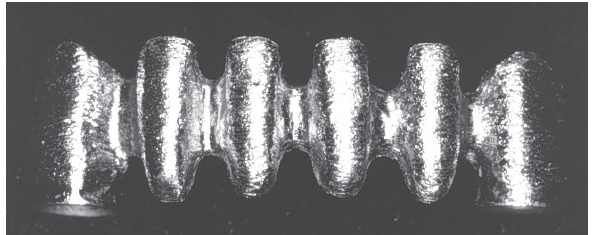
FIGURE 2- Labial view of cast framework